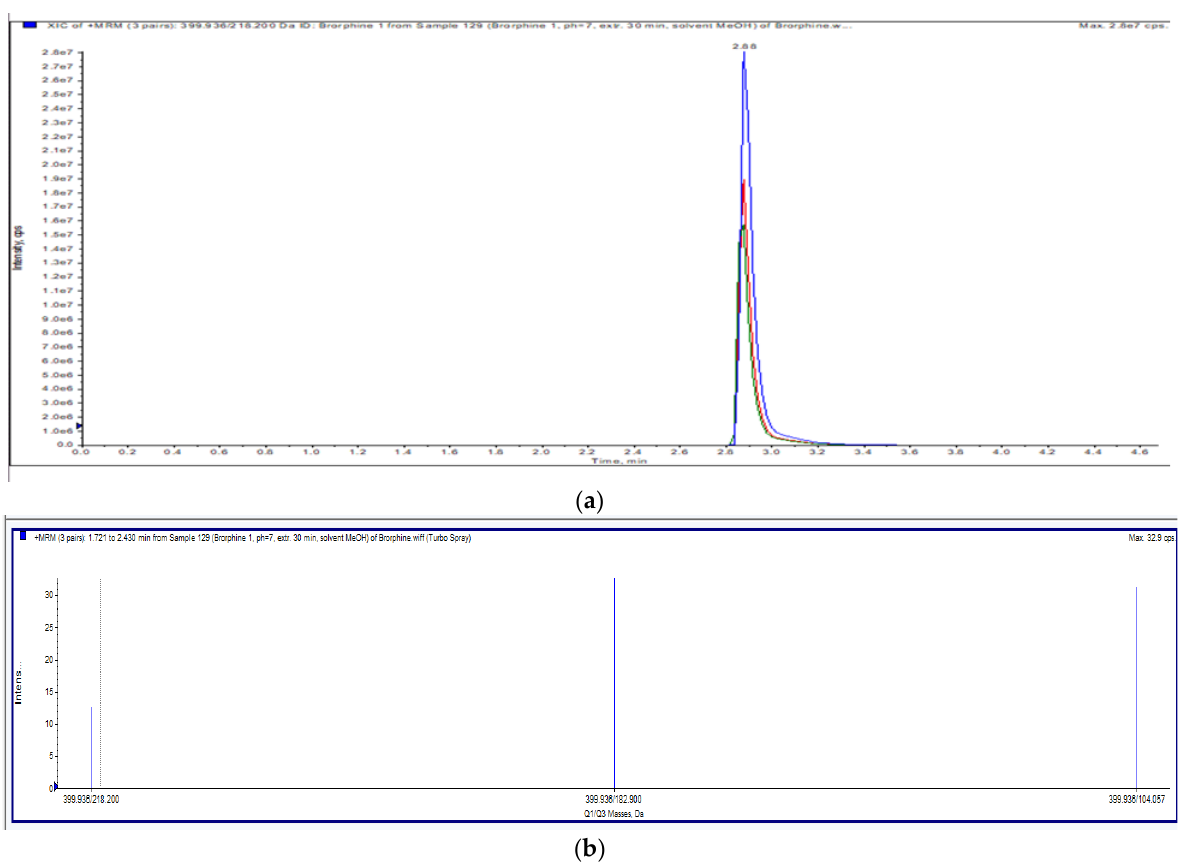
Figure 2. ( a ) Total ion chromatogram (Full scan) of brorphine. ( b ) Ion spectra of brorphine.